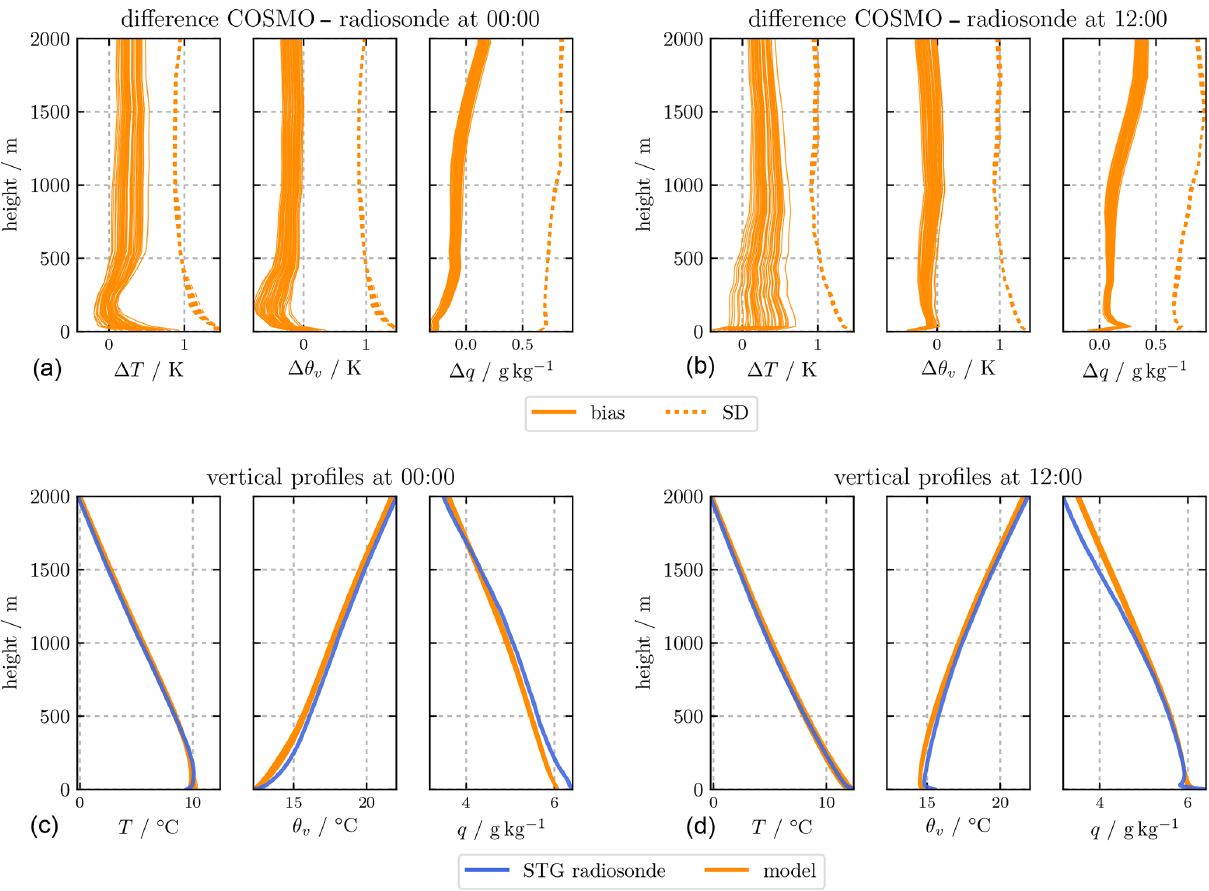
Figure 9. Mean vertical profiles of temperature, virtual potential temperature, and specific humidity (a, b) , and mean differences between modeled and observed data including the standard deviation of the differences (c, d) . The experimental data are from the radiosonde data at STG and the simulated data from the grid boxes of the simulated catchment with different land cover ( a, c : 00:00LT, b, d :